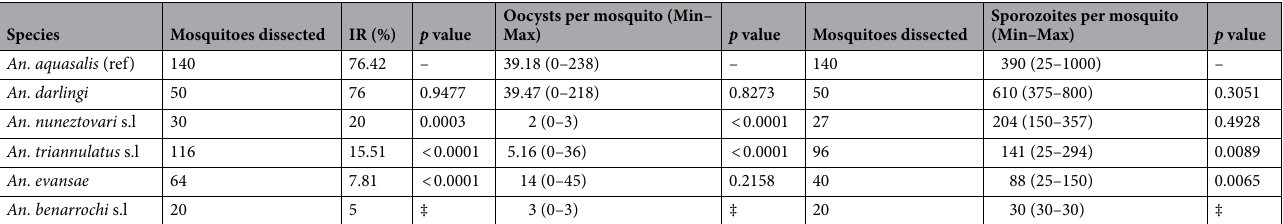
Table 1. Susceptibility of six Amazonian Anopheles species fed with blood samples obtained from malaria- infected patients. Ref reference; IR Infection rate; ‡: not included in the